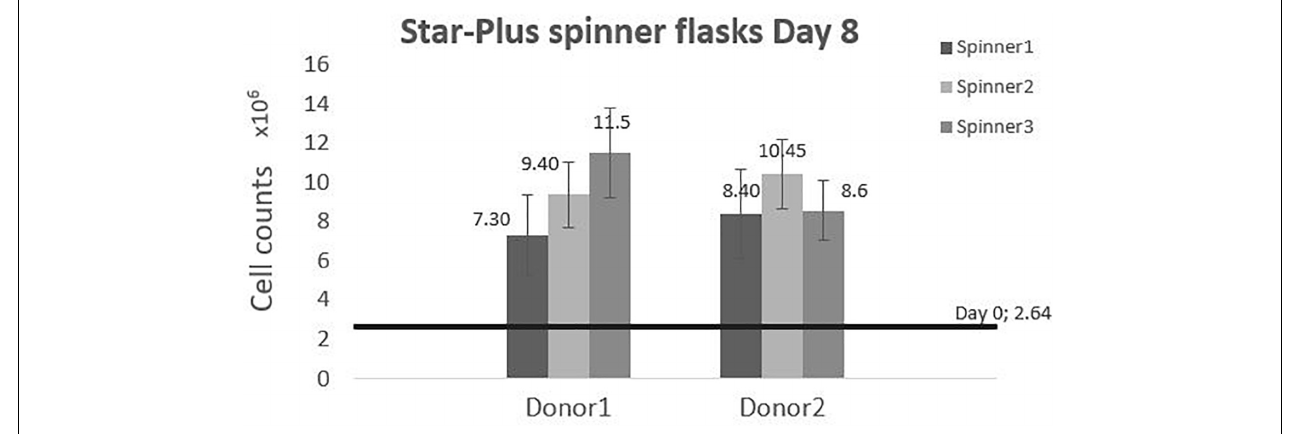
FIGURE 7 | Cell counts of the dynamic Star-Plus evaluation for each of the triplicate spinners of each donor.